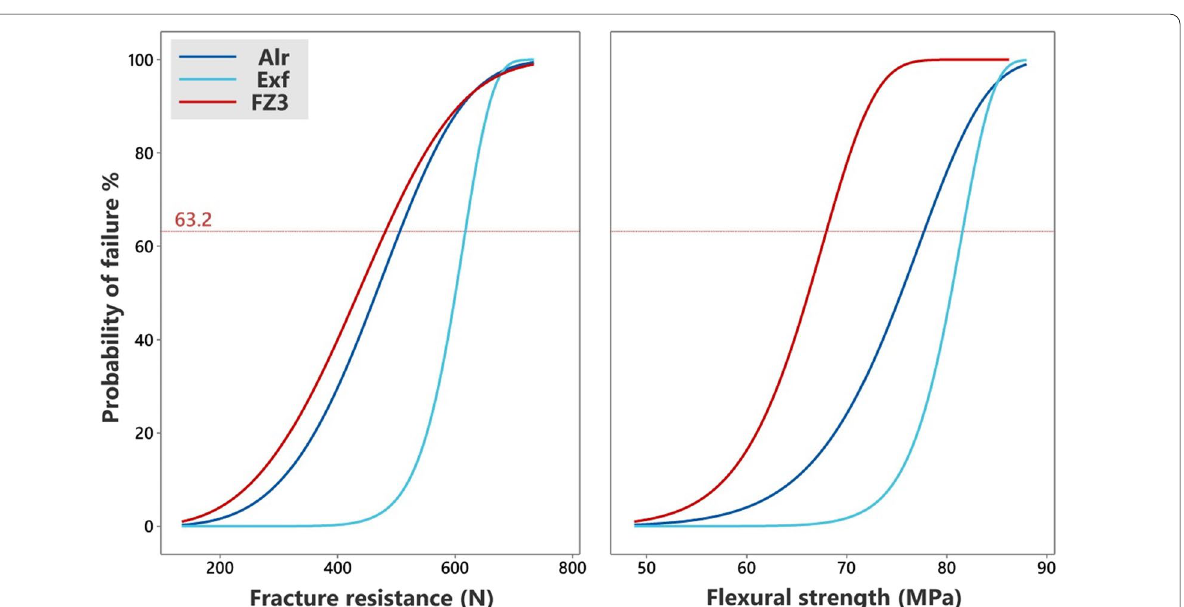
Different superscript letters or symbols inside the α column for each parameter are statistically significant differences based upon a 95% confidence interval (CI). α: characteristic strength or scale of a Weibull parameter. β: the shape, slope, and modulus of a Weibull parameter. P10: estimation at 10% probability of failure